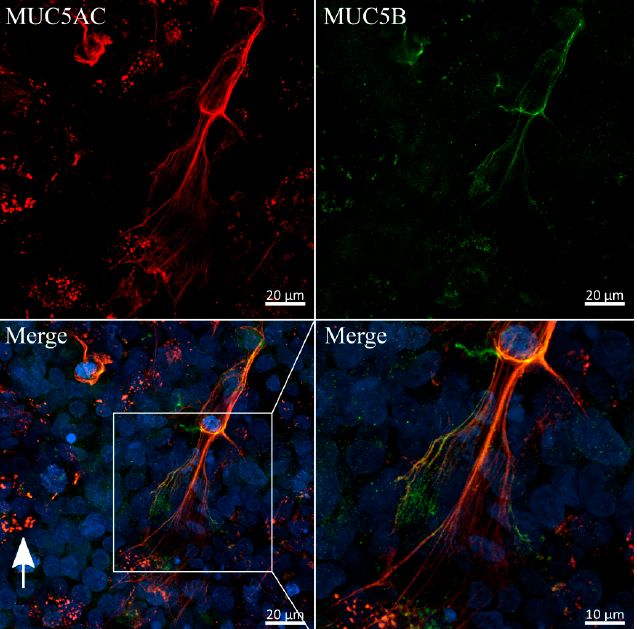
Figure 6. Colocalization and fiber-formation of secreted mucins MUC5AC and MUC5B. Confocal immunofluorescence images of HT29-MTX cells after two weeks of dynamic culture stained with antibodies for MUC5AC (red) and MUC5B (green). Nuclei were counterstained with Hoechst 33342 (blue). White arrow indicates an example of colocalization of both mucins in secretory vesicles.